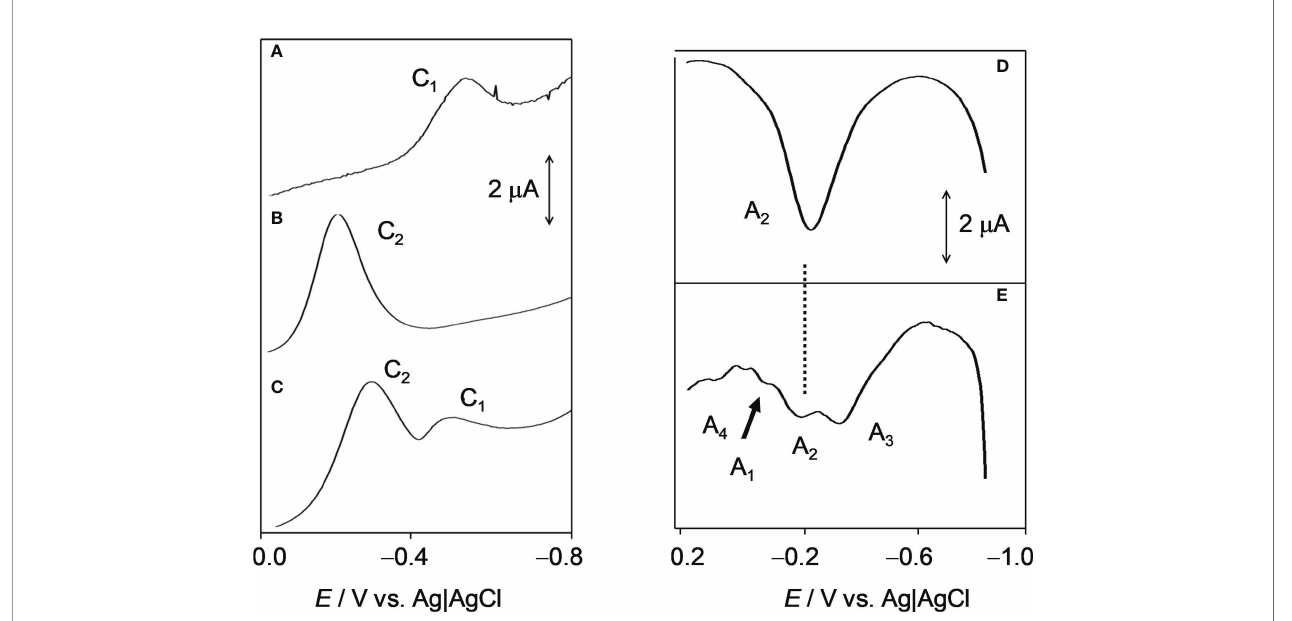
FIGURE 3 | Square wave voltammetric curves of a vitamin K1 fi lm on a glassy carbon electrode (A) and deposits of uninfected blood (B) and infected erythrocytes (C) on a glassy carbon electrode in contact with 0.10 M phosphate buffer saline at pH 7.4. Potential scan initiated at 0.0 V in the negative direction (potential step increment, 4 mV; square wave amplitude, 25 mV; frequency, 10 Hz). Square wave voltammetric curves of deposits of uninfected (D) and P. falciparum- infected erythrocytes (E) on glassy carbon electrode in contact with 0.10 M PBS at pH 7.4. Potential scan initiated at − 0.85 V in the positive direction; potential step increment, 4 mV; square wave amplitude, 25 mV; frequency, 10 Hz. C 1 , C 2 , (A 1 , A 2 , A 3 , A 4 ) denote cathodic (anodic) signals corresponding to electrochemical reduction (oxidation) processes described in detail in the